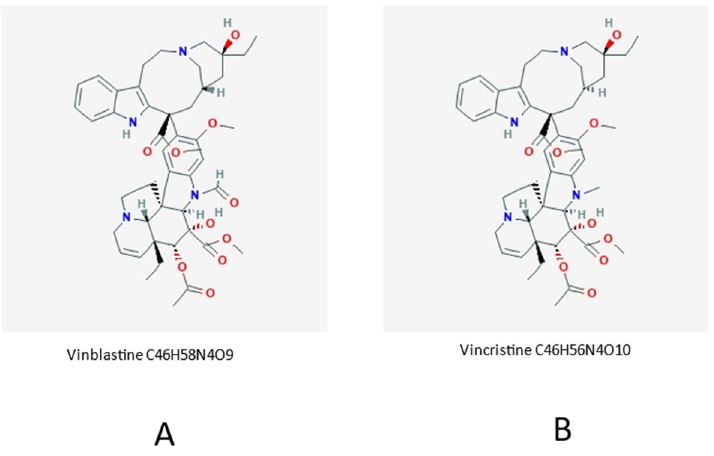
Figure 2. Chemical formulas of vinblastine ( A ) and vincristine ( B ). The close molecular/chemical analogy of the two active principles is evident. Vin- blastine is commercially sold as Velban but is also known under different brand names. Vincristine (also named leurocristine) is found on the market under the brand name On- covin but, as in the previous case, different brand names are commercially